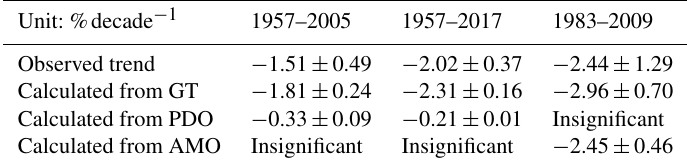
Table 3. Comparison of observed linear trends in bottom 10% light precipitation with calculated trends for three time